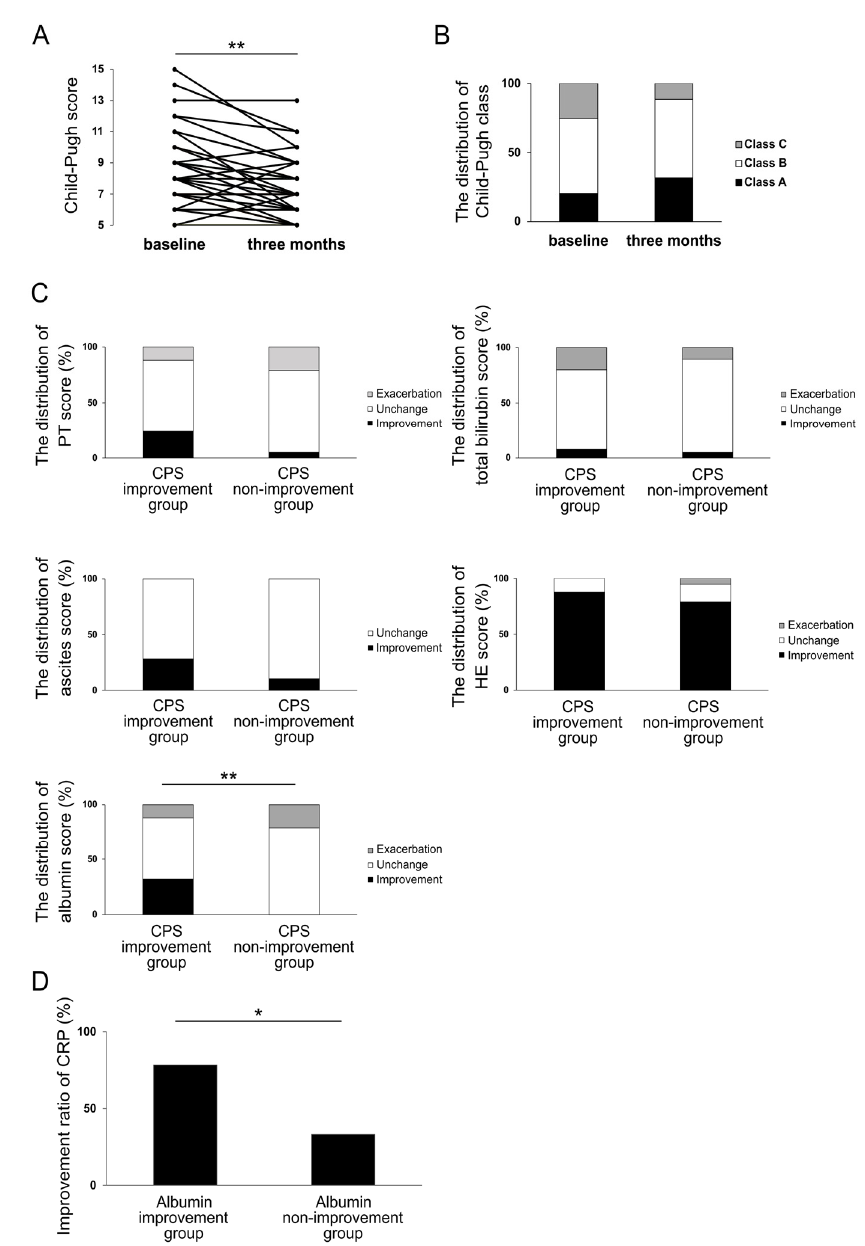
Figure 4. CPS ( A ) and the distribution of Child–Pugh class ( B ) at three months of rifaximin administration. The distribution of changes in CPS parameters in CPS improvement group and CPS non-improvement group at three months of rifaximin administration ( C ). The distribution of changes in CRP in albumin improvement group and albumin non-improvement group at three months of rifaximin administration ( D ). * p < 0.05, ** p < 0.01. CPS, Child–Pugh score; CRP, C-reactive protein.